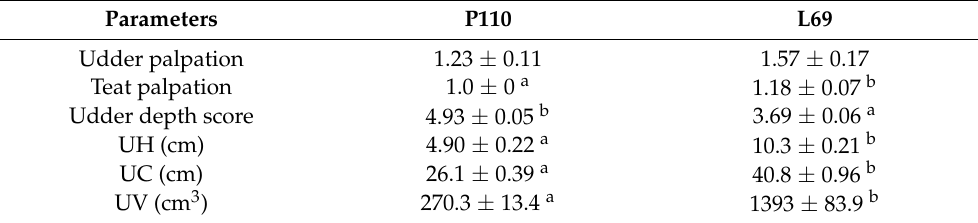
Table 2. Effect of time (day 110 of pregnancy (P110) and weaning of the lambs (L69)) on udder and teat palpations, udder depth score, udder height (UH), circumference (UC), volume (UV). Least square means ± s.e.m.